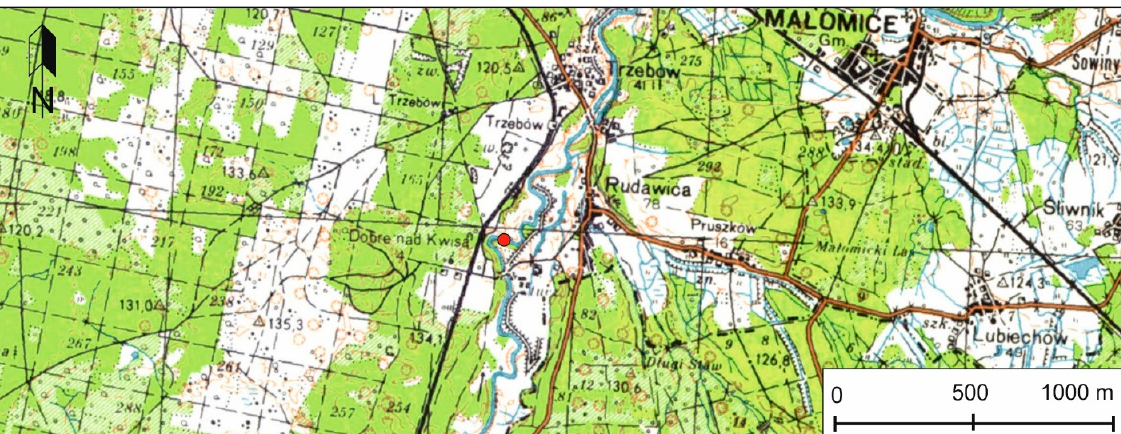
Figure 5. Location of the proposed SHPP Rudawica. Table 4. Values of factors in the HAFIPES system for prospective SHPPs.